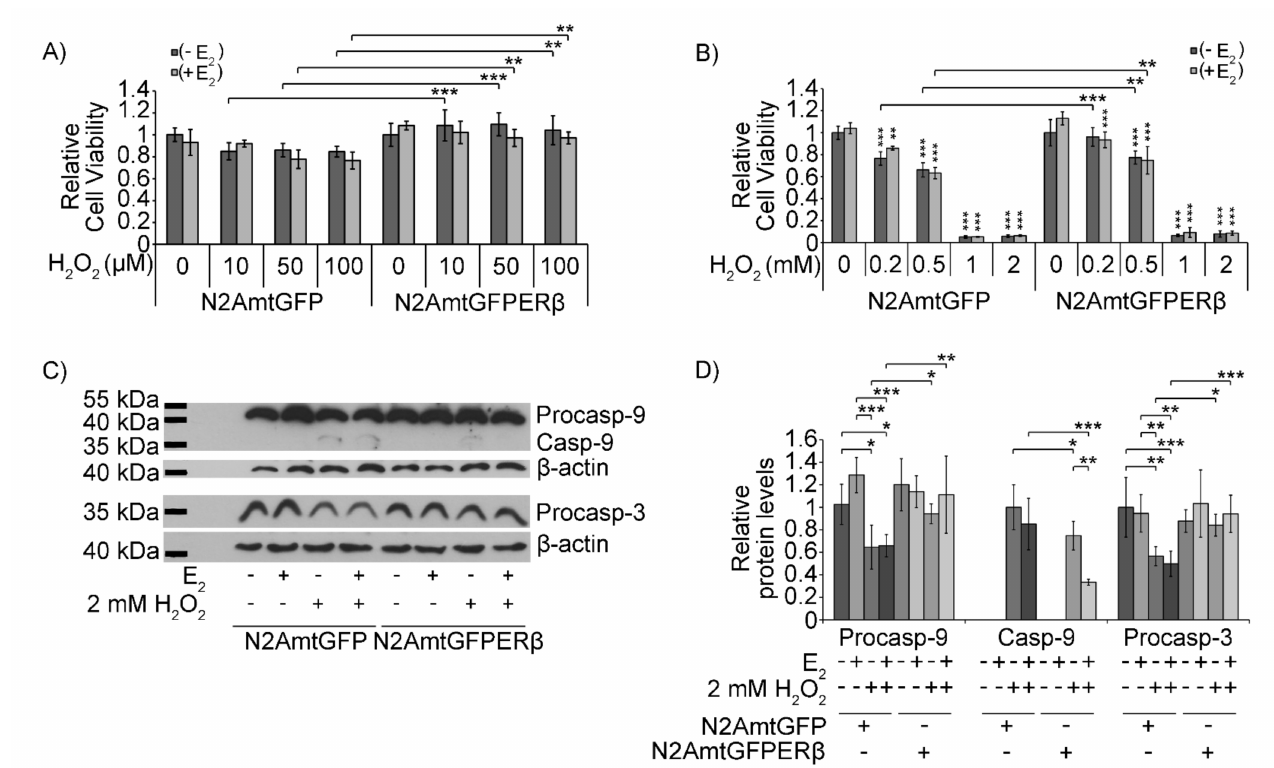
Figure 4. Protective effect of mtER β on H 2 O 2 -induced apoptosis. Assessment of the relative cell viability of N2AmtGFP and N2AmtGFPER β cells upon treatment with 10 to 100 µ M H 2 O 2 ( A ) and 0.2 mM to 2 mM H 2 O 2 ( B ) for 12 h, in the presence or absence of 10 − 9 M E2, via MTT analysis. Data were analyzed by two-way ANOVA and expressed as mean ± S.D. ( n = 4–6), ** p < 0.01, *** p < 0.001. Vertical asterisks represent statistically significant differences compared to the respective vehicle-treated cells of each cells line, while horizontal lines and the respective asterisks corresponds to statistically significant differences between the two types of cells subjected to the same treatment, as indicated. ( C ) Western blot analysis of procaspase-9 and -3 and cleaved caspase-9 in N2AmtGFP and N2AmtGFPER β cells, treated with 2 mM H 2 O 2 , in the presence or absence of 10 − 9 M E2, for 2.5 h. Western blot analysis of β -actin was applied for the normalization of the results. Quantification of the results is presented in ( D ). Band density of the highest expression level of each analyzed molecule, in the respective set of experiment, was set at 1. Data were analyzed by two-way ANOVA and expressed as mean ± S.D. ( n = 3–5), * p < 0.05, ** p < 0.01, *** p <